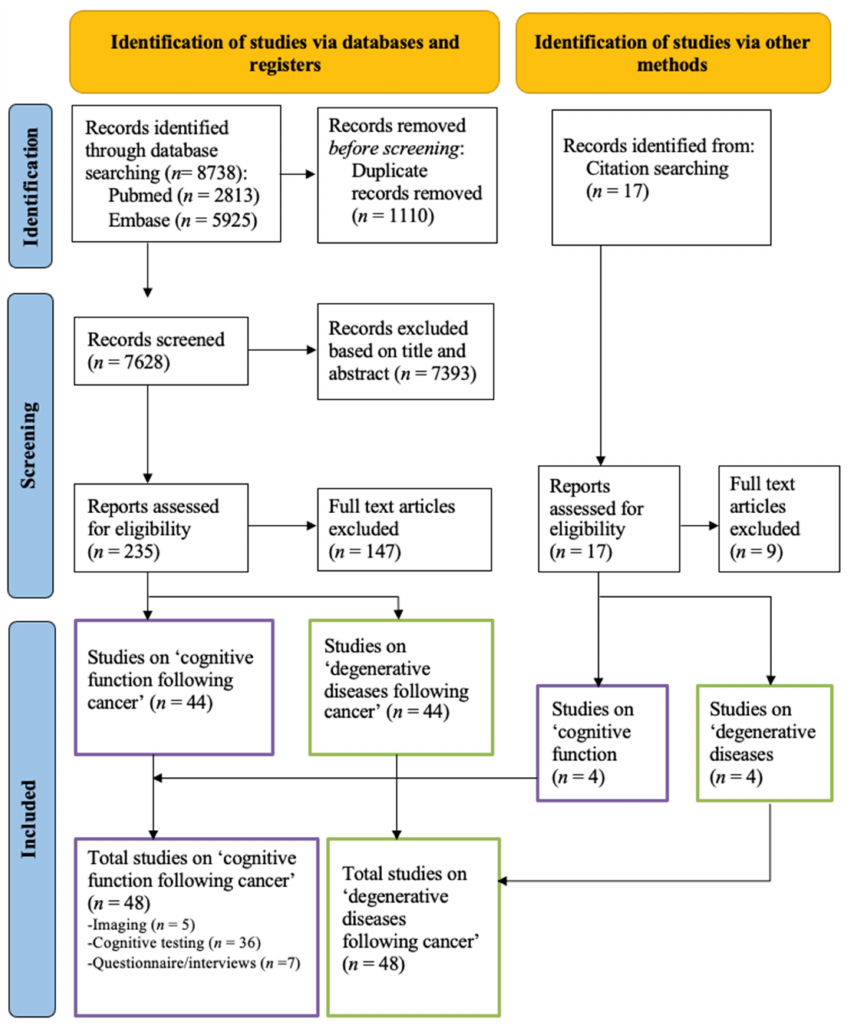
Figure 1. PRISMA 2020 flow